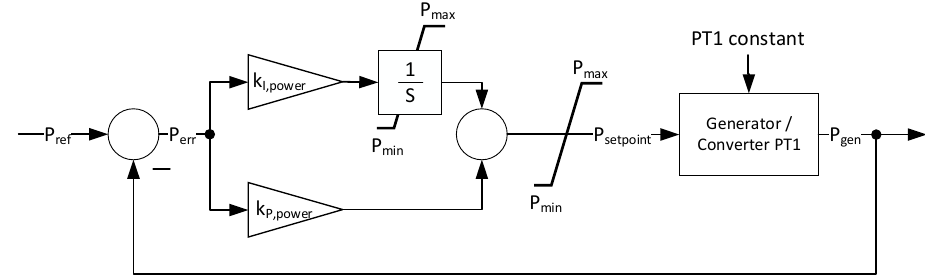
Figure 6. Block diagram of the power controller and the generator ‐ converter model.